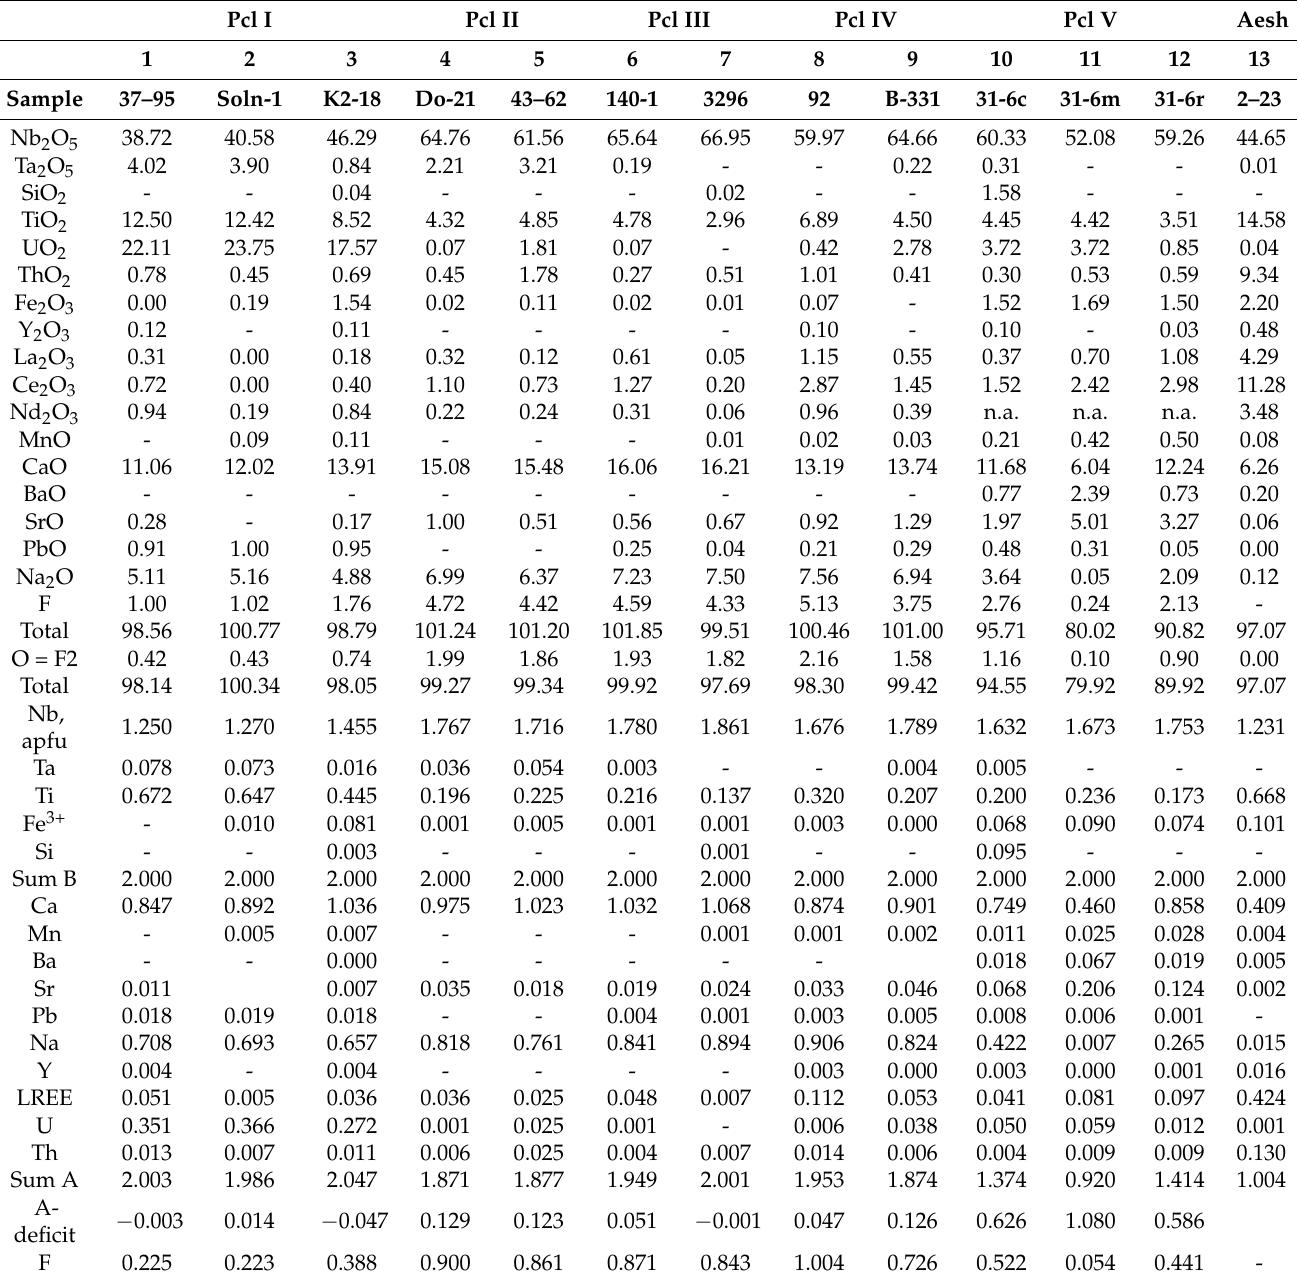
Figure 3. Representative compositions of pyrochlore and aeschynite group minerals of Buldym complex are given in Table 1. Table 1. Representative compositions (wt%) of the pyrochlore and aeschynite group minerals of carbonatite complexes of the